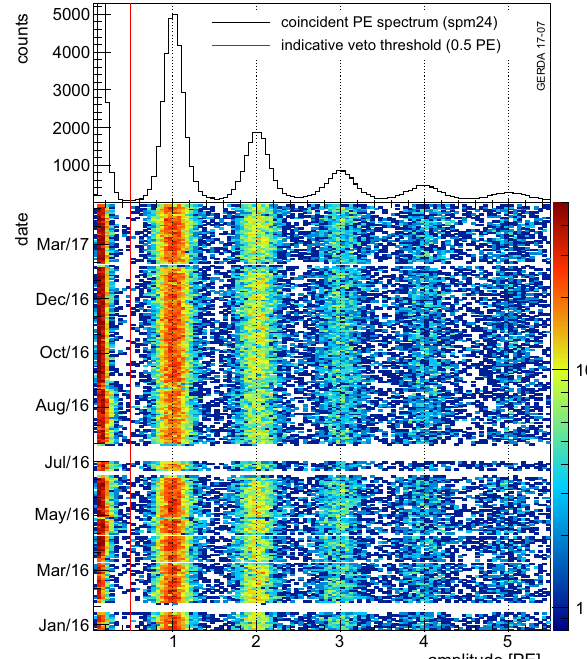
Fig. 26 Same as Fig. 25 but for a SiPM channel representing 6 SiPMs read out in parallel